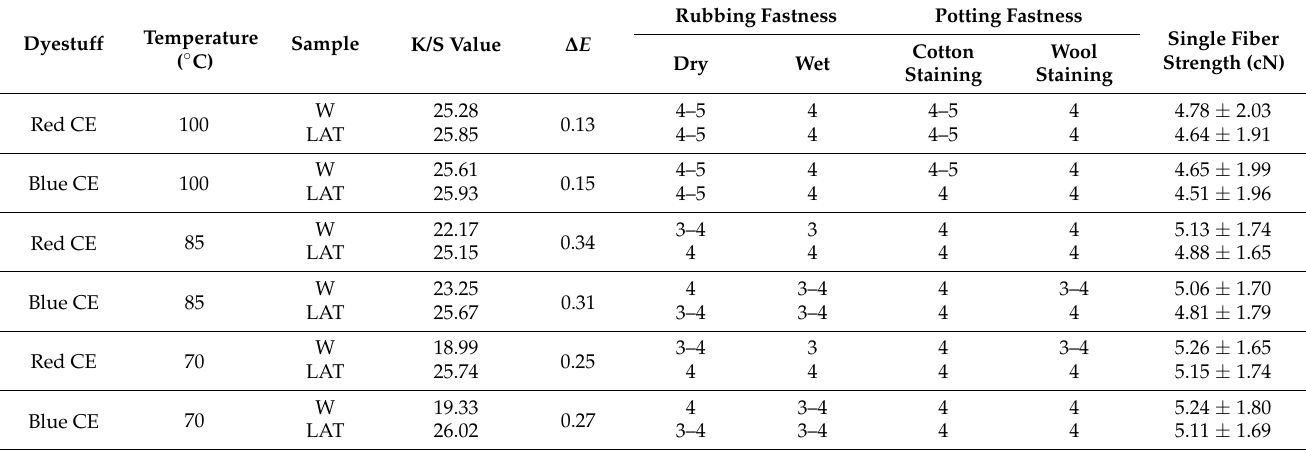
Table 2. Dyeing properties of W and LAT dyed at 100 ◦ C, 85 ◦ C and 70 ◦ C for 60